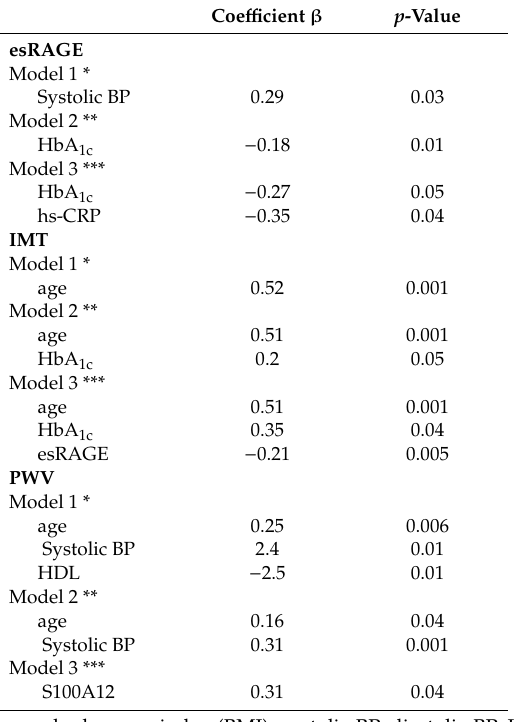
Figure 1. Circulating levels of soluble receptor for advanced glycation end-products (sRAGE) ( A ), endogenous secretory RAGE (esRAGE) ( B ), S100A12 ( C ), and carboxymethyl-lysine (CML) ( D ) (mean ± SD) according to glucose tolerance and 1 h postload plasma glucose. * p < 0.05 vs. CTRL. Table 3. Multiple regression analysis evaluating esRAGE, IMT, and PWV as dependent